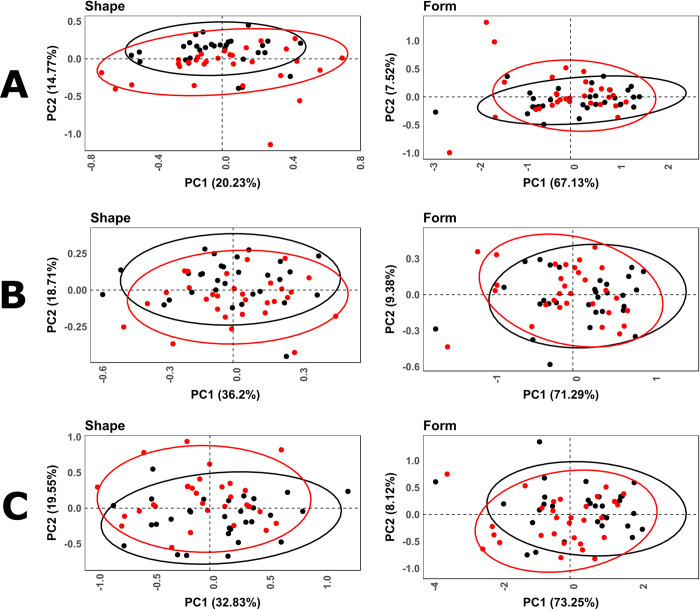
Scatter plots for principal components analysis results comparing different landmark configurations for (Red) dog and (Black) wolf tooth pits.(A) 17-Landmark model in (Left) shape and (Right) form. (B) 5-Landmark model in (Left) shape and (Right) form. (C) 30-landmark model in (Left) shape and (Right) form. Ellipses represent 95% confidence intervals.